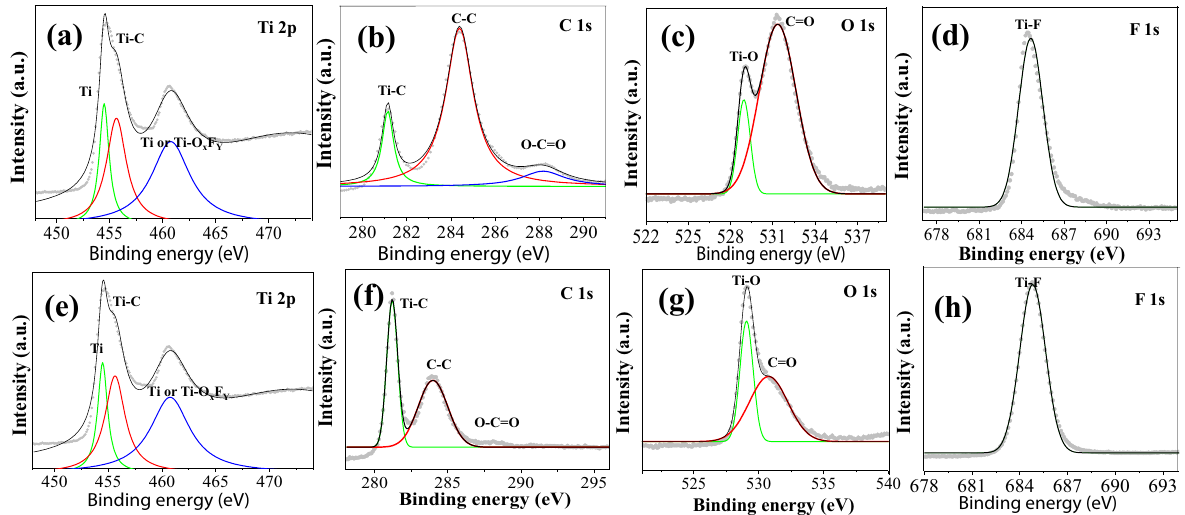
Figure 3. Highly resolved XPS spectra of Ti 2p, C 1 s, O 1 s, and F 1 s peaks in ( a – d ) M1 and ( e – h ) M4,